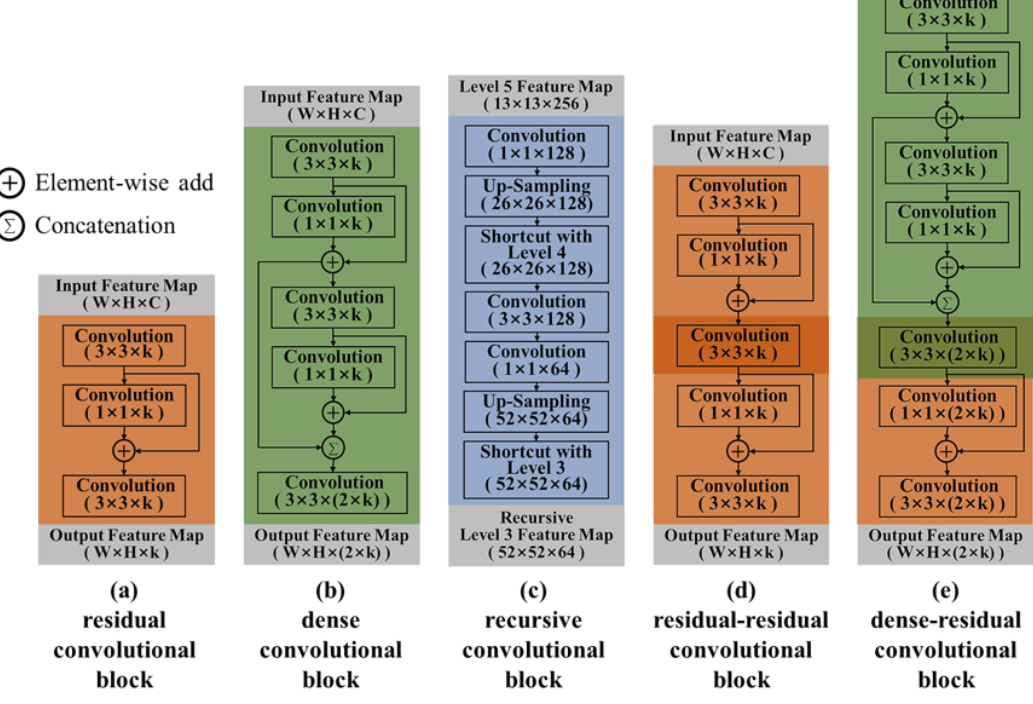
Figure 3. Scalable convolutional